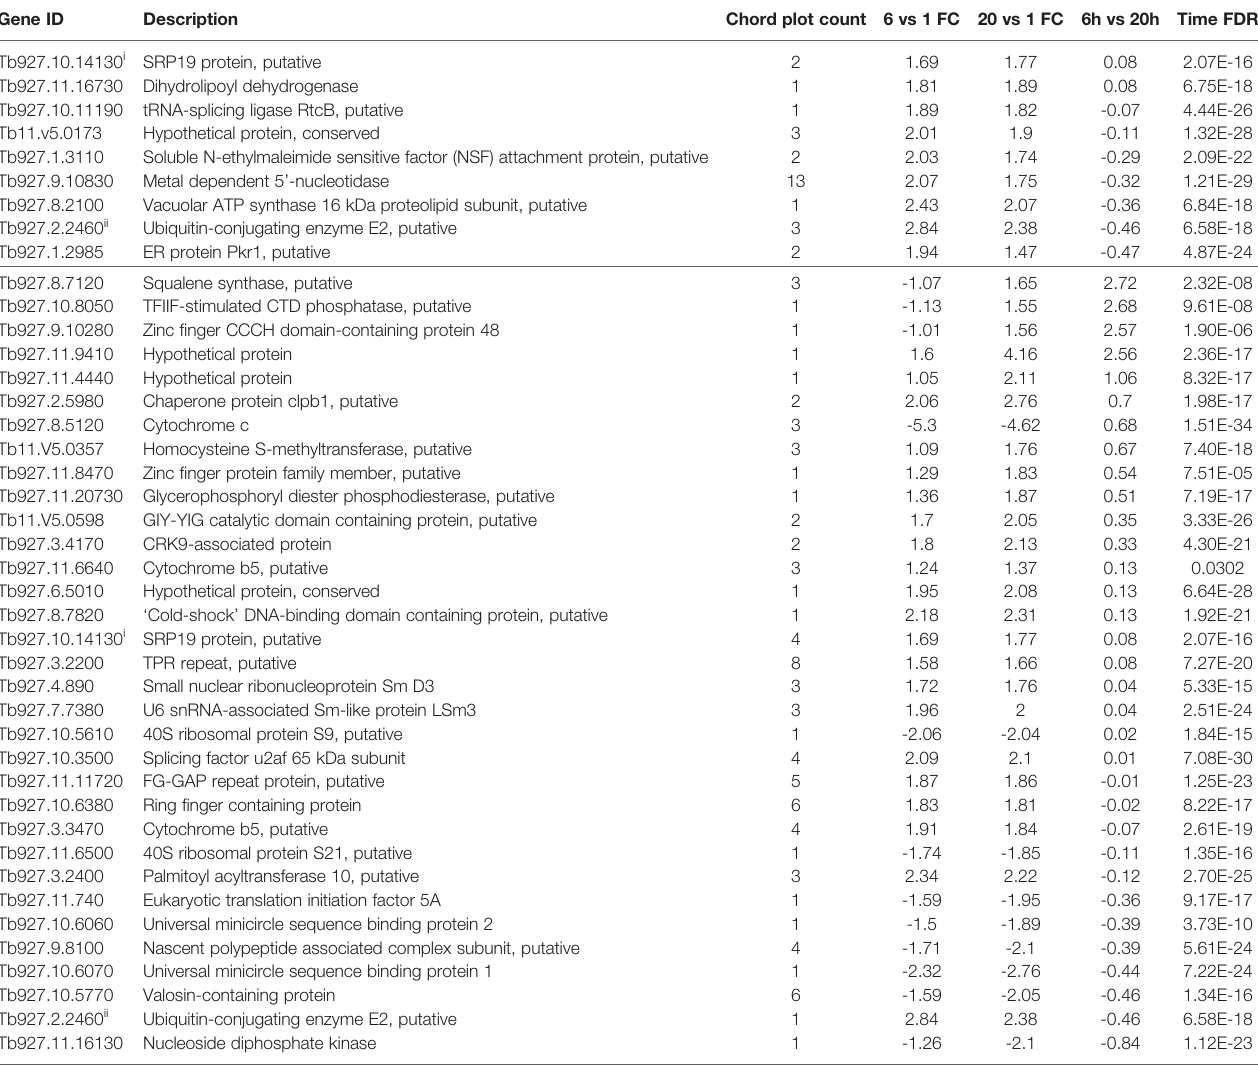
TABLE 3 | Genes found in positive Z score GO terms for 100Gy at 6h and 20h post-irradiation. Gene ID